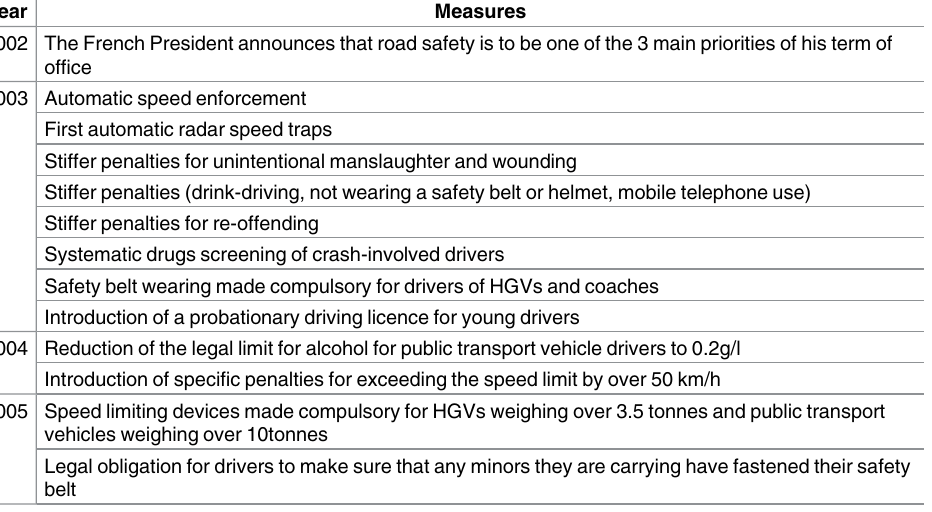
Table 7. law enforcement timetable since 2002 in France Year Measures